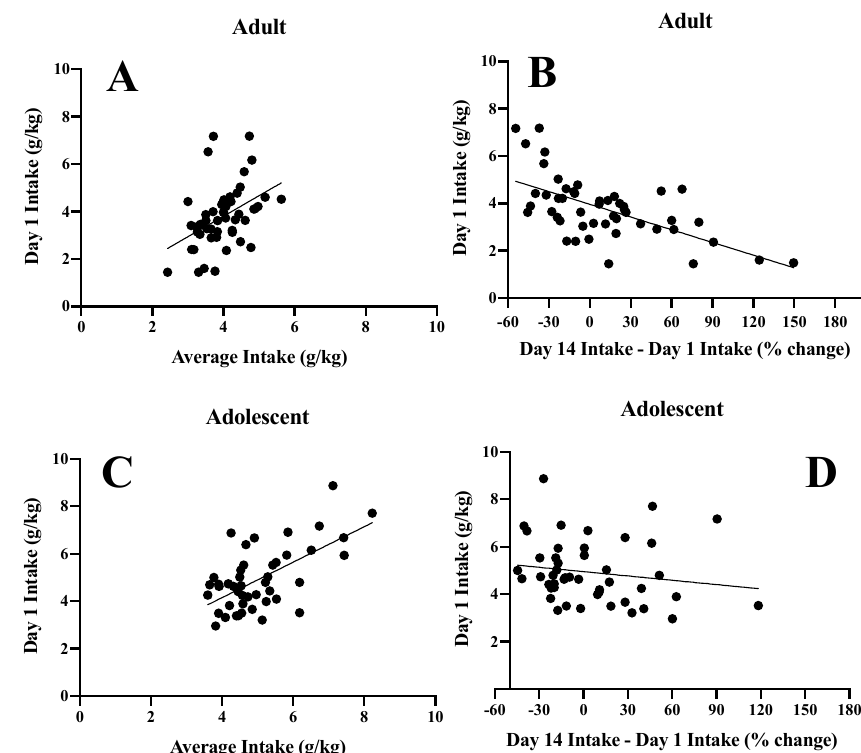
Figure 14. Summary of the significant inter-relations between measures of alcohol intake. A predictive relationship was observed between alcohol intake on Day 1 of drinking and the average alcohol intake over the 14-day drinking period in both ( A ) adult and ( C ) adolescent mice. Conversely, initial alcohol intake was inversely related to the escalation of intake observed over the course of the 14-day drinking period in both ( B ) adult and ( D ) adolescent mice.